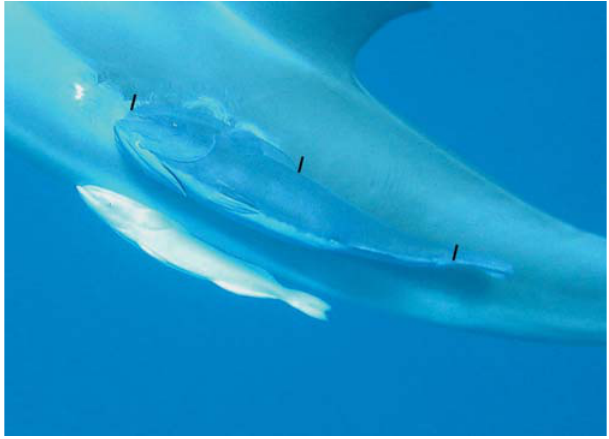
Fig. 2 Whalesuckers ( Remora australis ) attached to a spin- ner dolphin showing relative size of sucking disk, body shape, and two color patterns. Bars mark sucking disk and standard lengths. Photo taken in the Baía dos Golfinhos at Fernando de Noronha, courtesy J. M. Silva Jr.